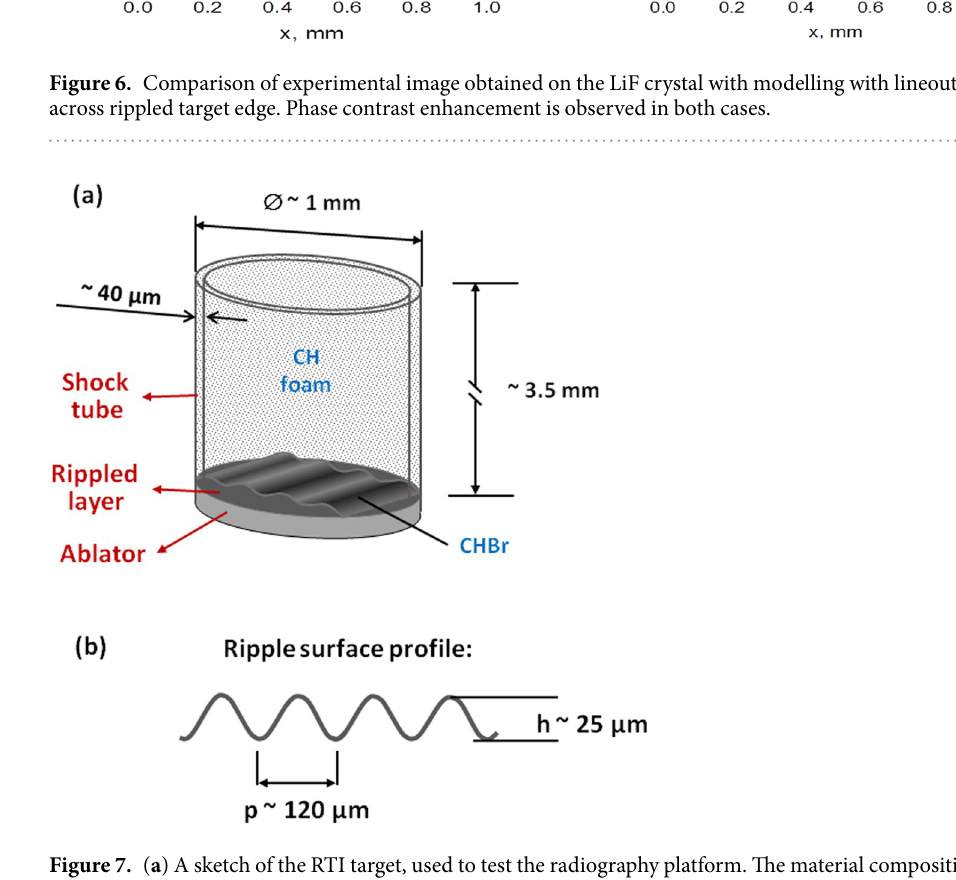
Figure 7. ( a ) A sketch of the RTI target, used to test the radiography platform. The material composition and the dimensions of the targets are shown. ( b ) The parameters of the pre-imposed ripples on the